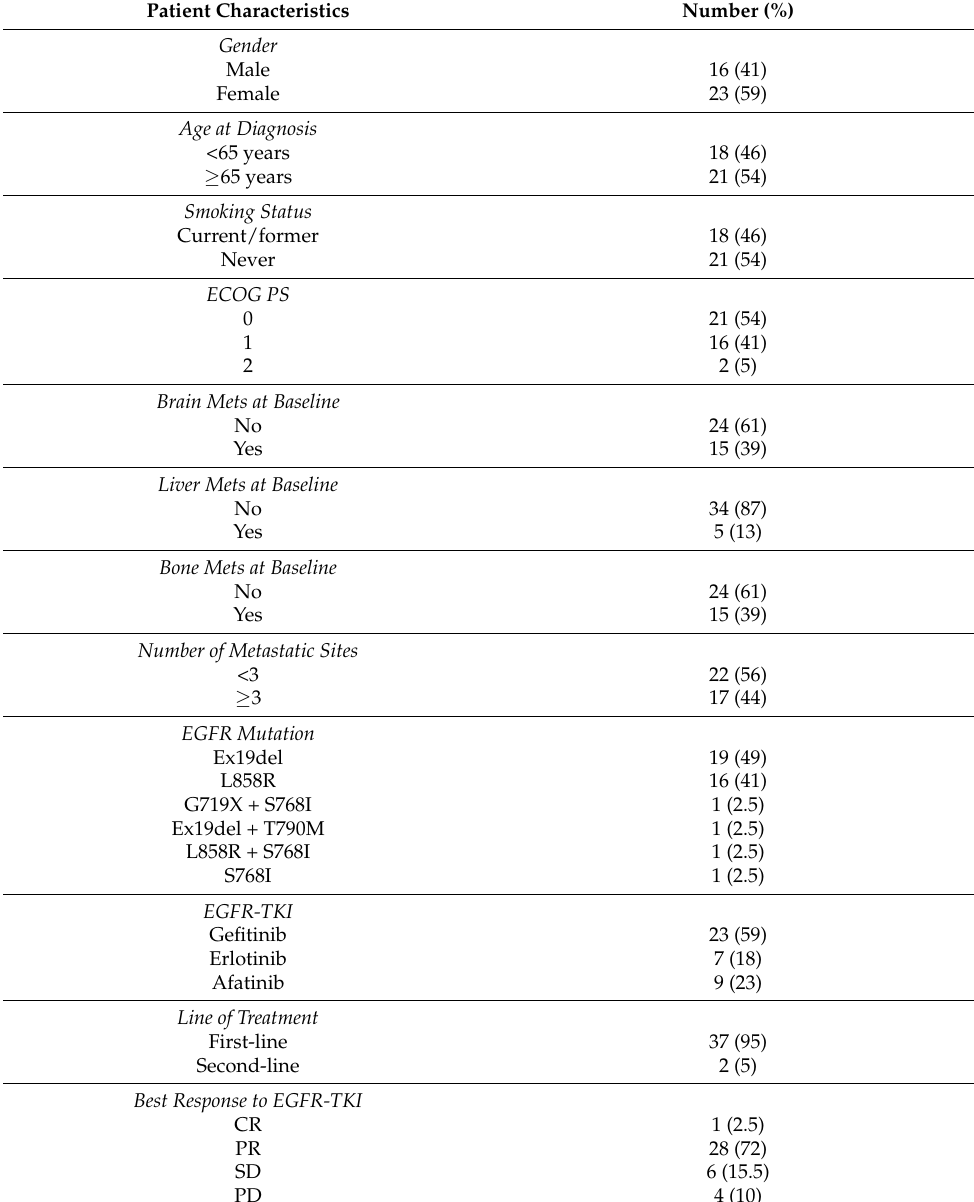
Table 1. Patient